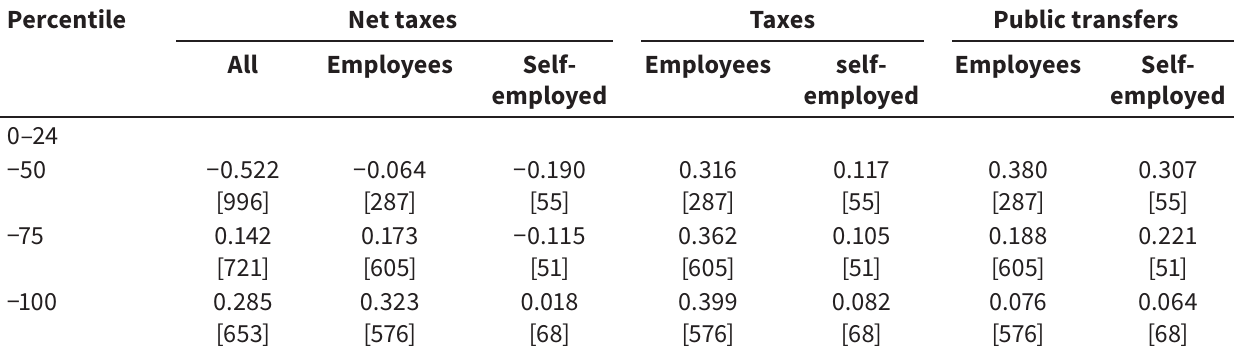
Household average effective net tax rates in Lithuania, net taxes as a share of gross employment income. Sample restricted to households with 1 household member aged 18–62, but can include older and younger household members as